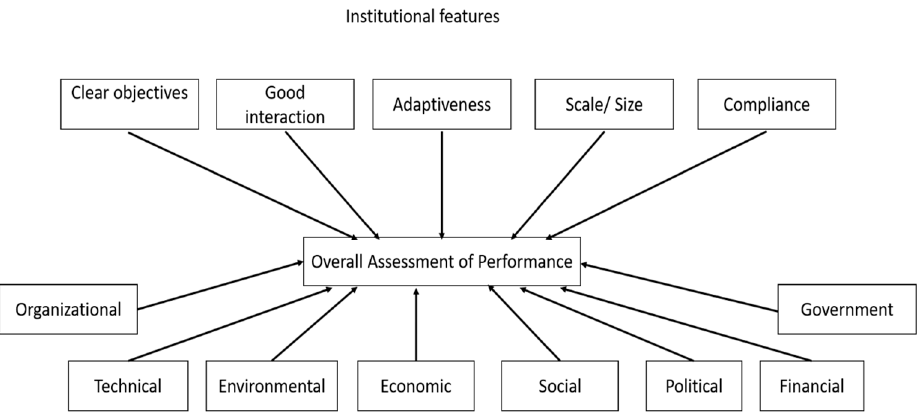
Figure 1. Overall assessment performance of the Water Use Associations (WUAs).